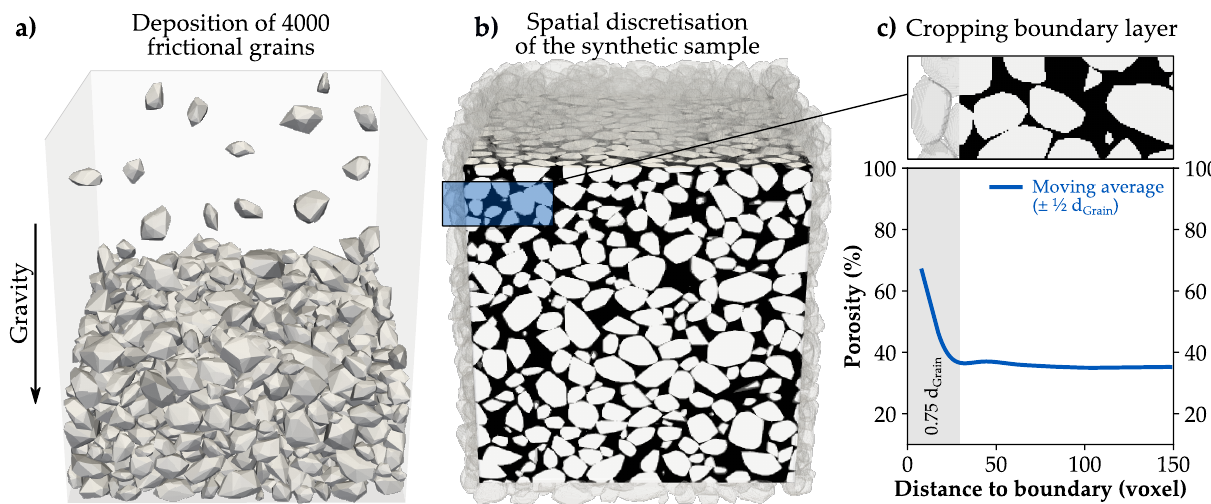
The workflow for constructing a synthetic sediment comprises ( a ) the gravity-driven deposition of 4000 grains, ( b ) the spatial discretisation of the sample for simulation purposes and ( c ) the removal of the highly porous boundary layer of 0.75 d Grain .